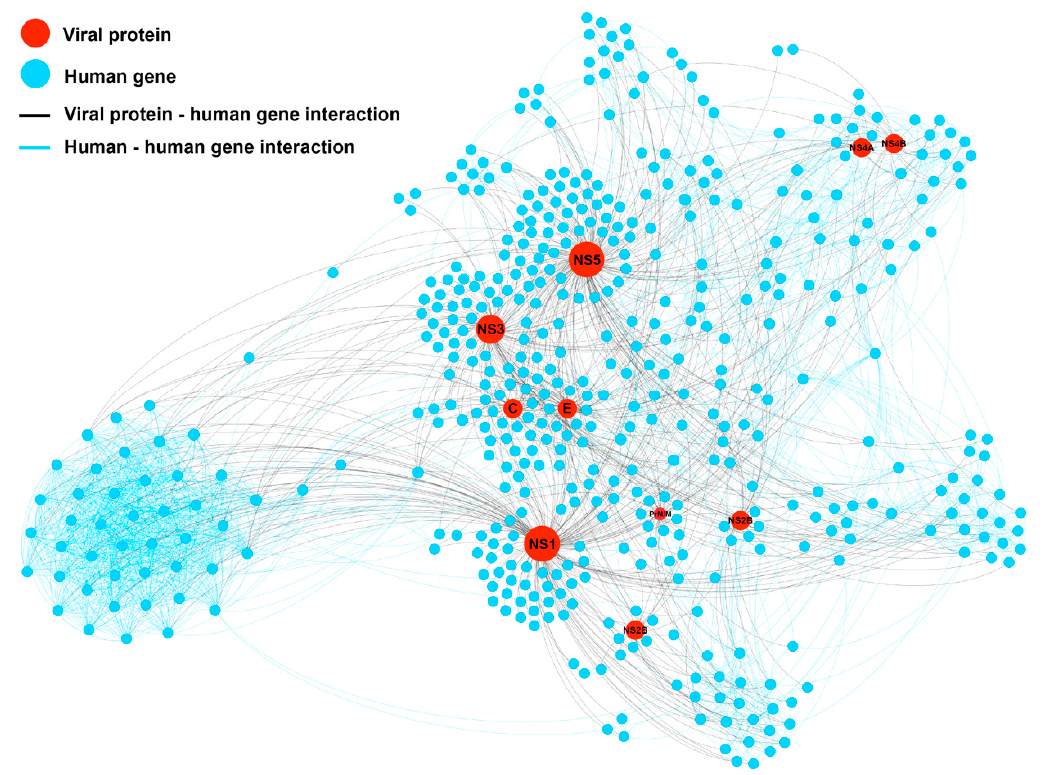
Figure 3. Protein-protein interaction network (DenvIntS) of DENV (red node), and the human related proteins from STRING PPI database (blue node). The interaction of DENV-human and human-human is represented as a black and blue line, respectively. The proportion of nodes is not referred to any parameters. Table 2. The whole network property of DENV-human protein interaction network.